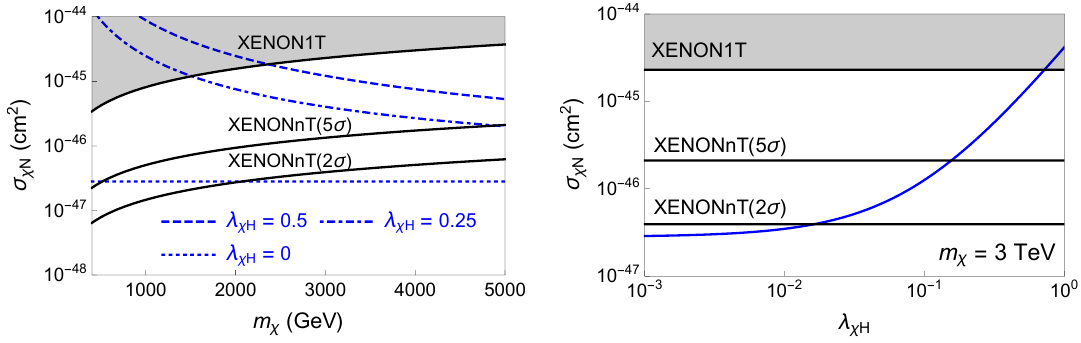
Figure 5 . The scattering cross section as a function of the dark matter mass m χ for several choices of the coupling λ χH (left panel) and as a function of λ χH with m χ being fixed to be 3 TeV (right panel). The cross section is compared with the present constraint from the XENON1T experiment [22] and the future expected sensitivity of the XENONnT experiment at 2 σ and 5 σ levels [23] in both